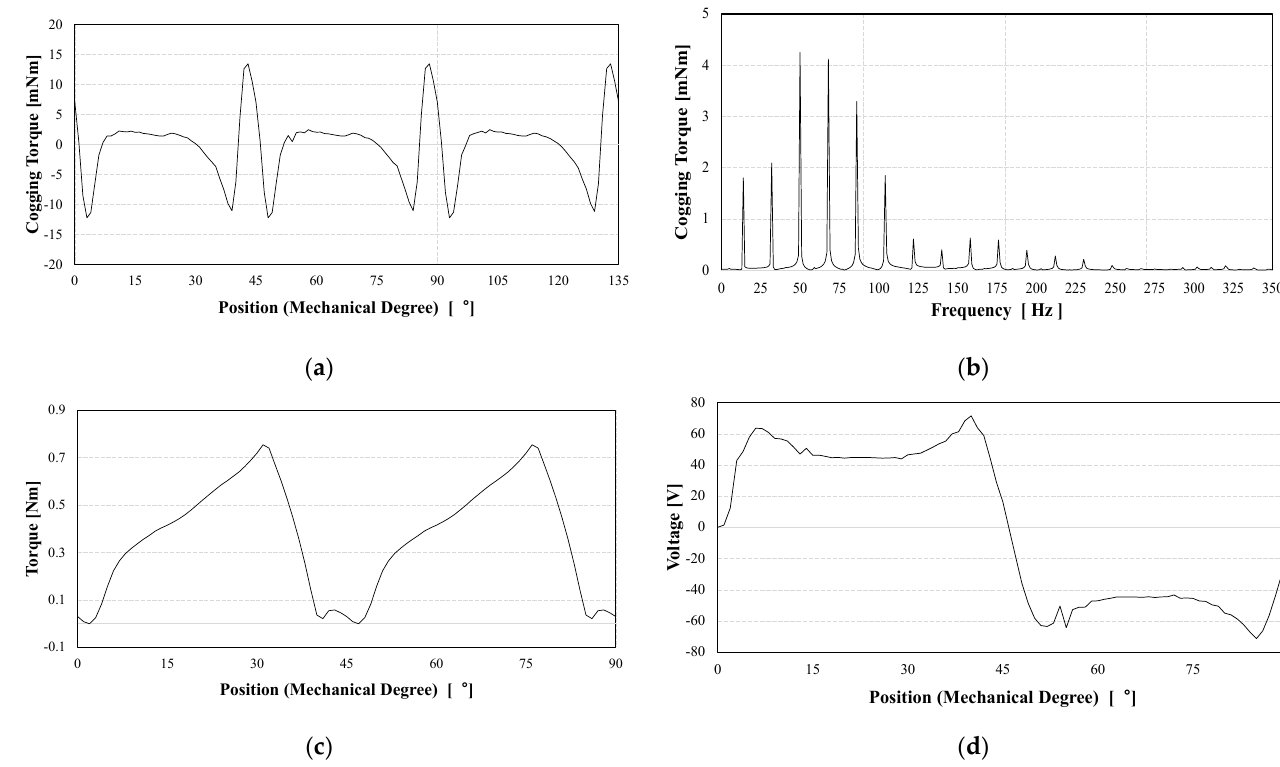
Figure 10. Optimal design results ( a ) cogging torque ( b ) FFT of cogging torque ( c ) torque ( d ) voltage.